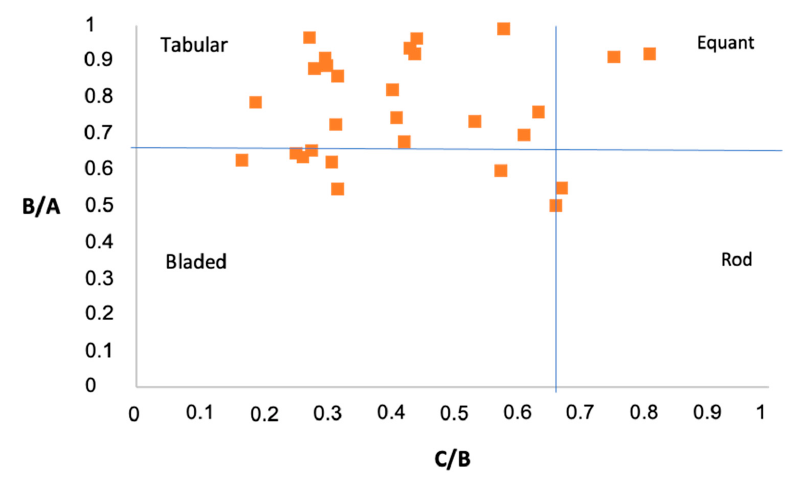
Figure 8. Zingg shape classification for the 31 selected boulders.